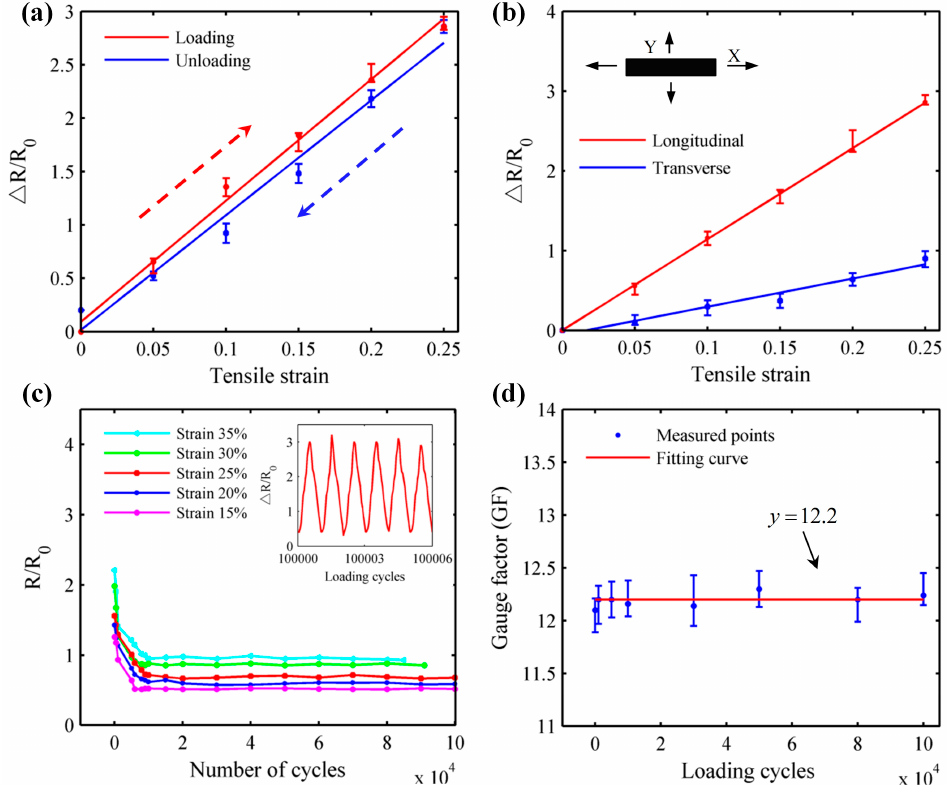
Figure 3. Elastic strain performances of fabricated nanocomposite specimens. ( a ) The sensor characteristics curves in single loading/unloading process; ( b ) The sensor response curves in both longitudinal ( X axis) and transverse ( Y axis) directions; ( c ) The resistance ratio of nanocomposite specimens under cyclic loading and unloading with the varying tensile strain (inset: the Δ R / R 0 of nanocomposite with tensile strain of up to 25%); ( d ) The GF response curve of specimen as a function of loading cycles.